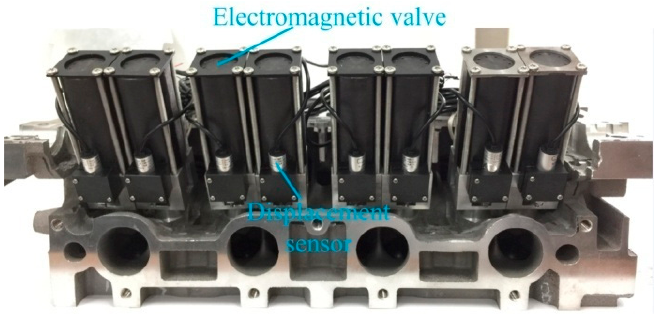
Figure 1. Test bench of engine cylinder head with EMVT.